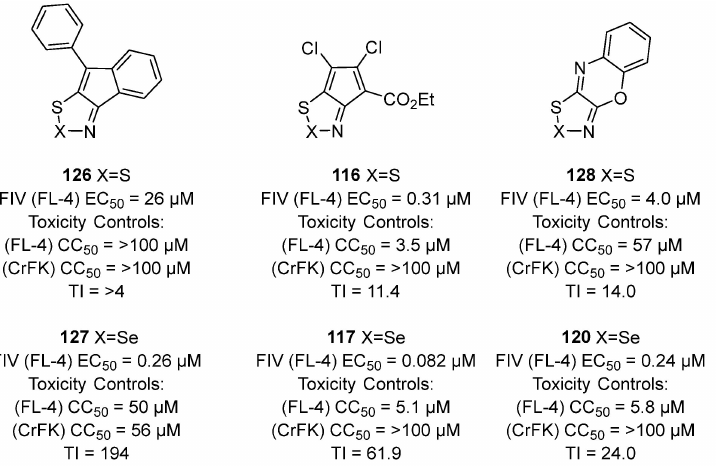
Figure 24. Summary active antiviral matched pair 1,2,3-dithiazoles and 1,2,3-thiaselenazoles.